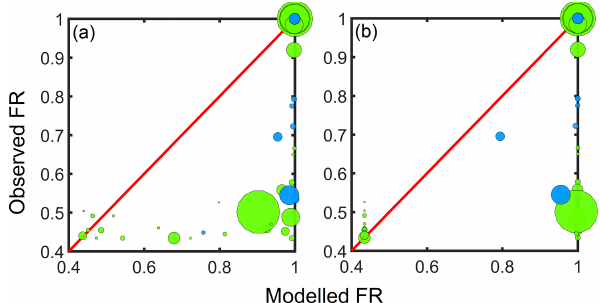
Figure B1. Similar to Fig. 6 except here the observed fraction re- maining (FR) is plotted against the FR modelled by (a) the Peräkylä et al. (2020) parameterisation and (b) the Bianchi et al. (2019) pa- rameterisation.